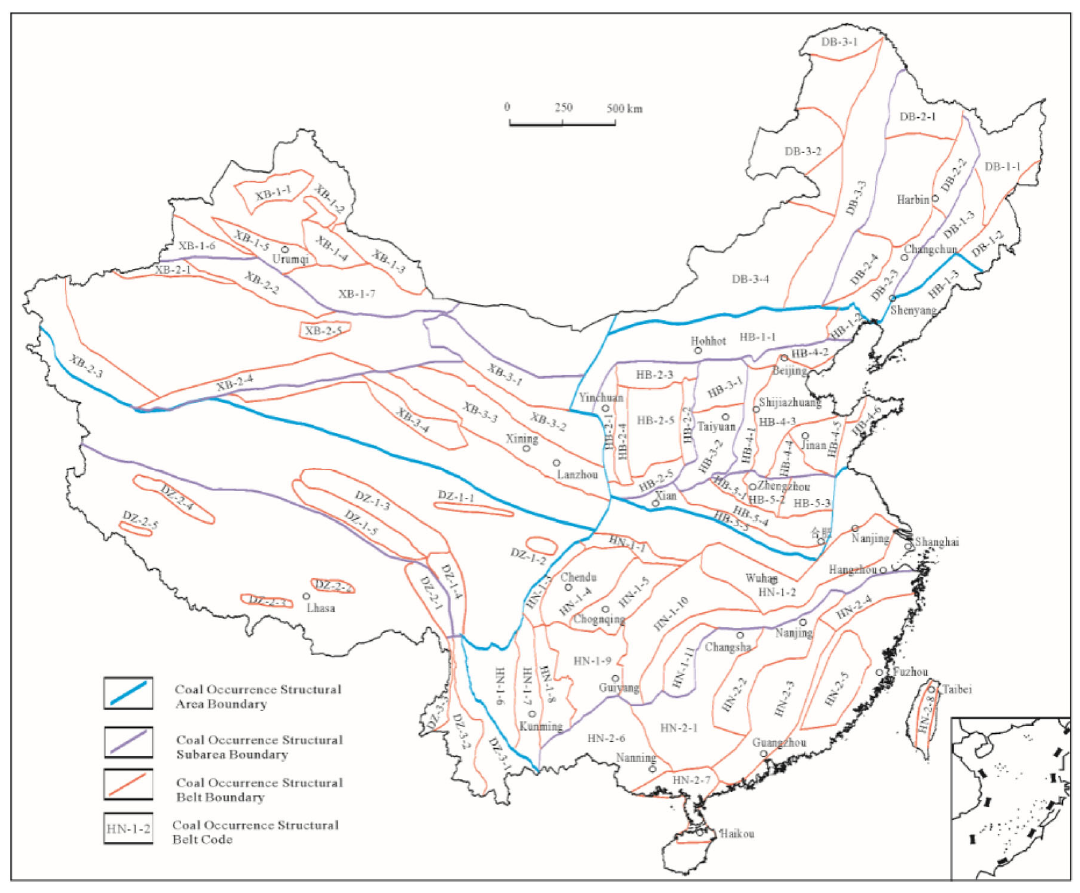
Fig. 2 Division of the coal occurrence structural units in